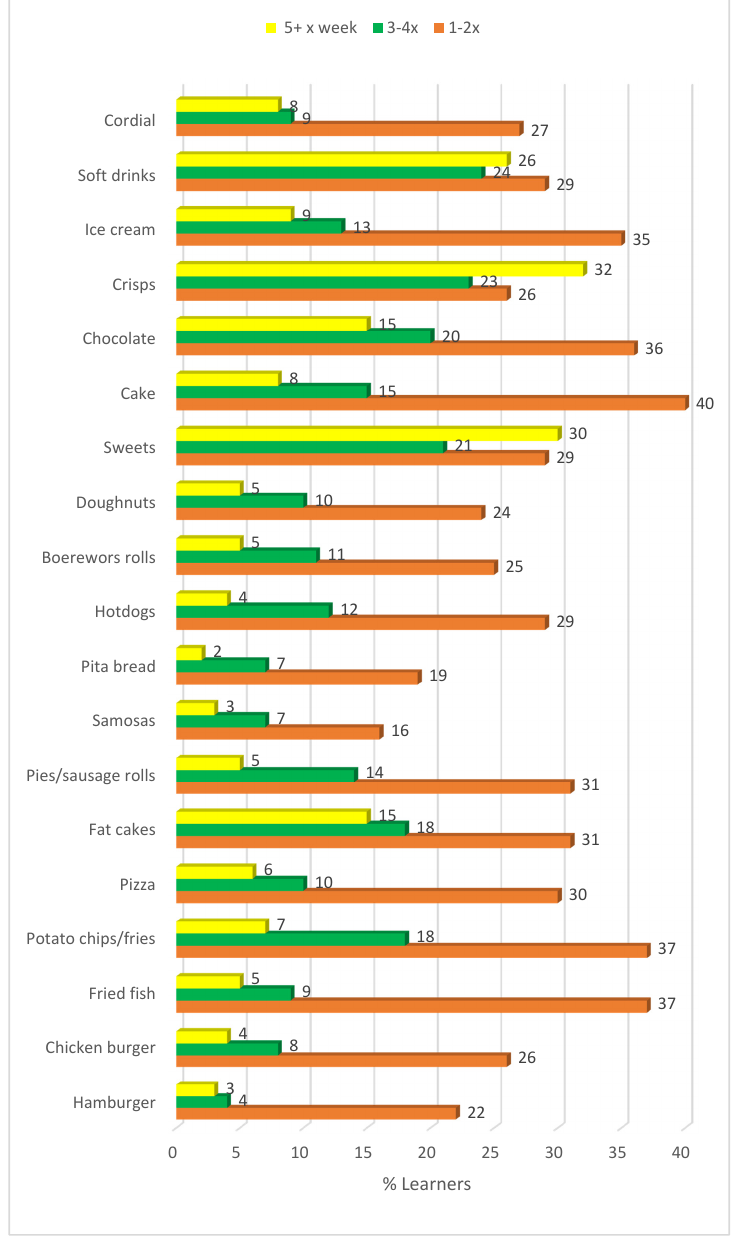
Figure 2. Food items reported to be purchased as take-aways during the past week by learners.